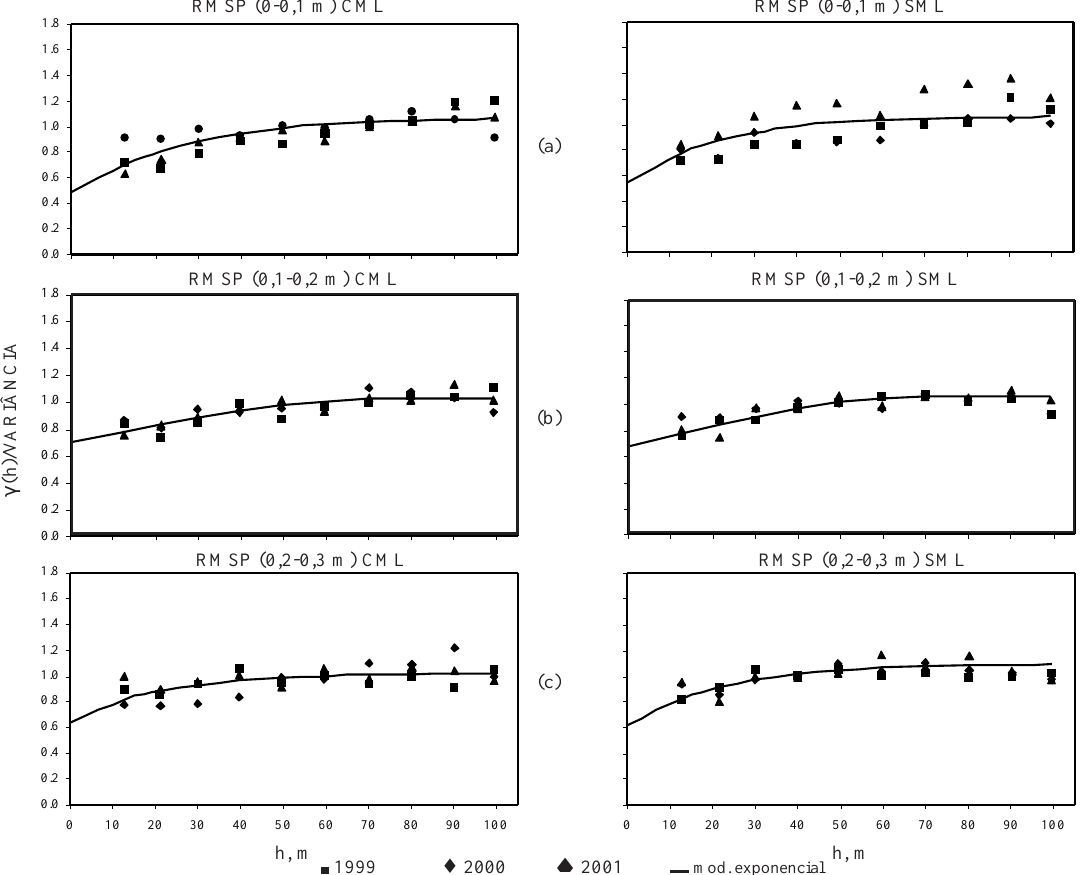
Figura 1. Semivariogramas escalonados para a variável RMSP (0-0,1 m) (a), (0,1-0,2 m) (b) e(0,2-0,3 m) (c), avaliada nos anos de 1999 a 2001, nas parcelas com e sem manejo químico localizado (CML e SML,